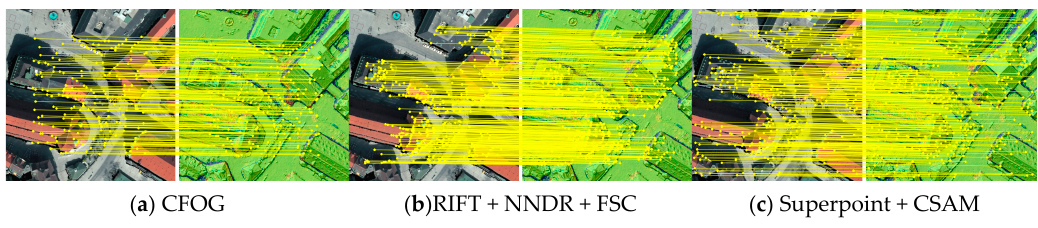
Figure 21. Optical–LiDAR matching results.